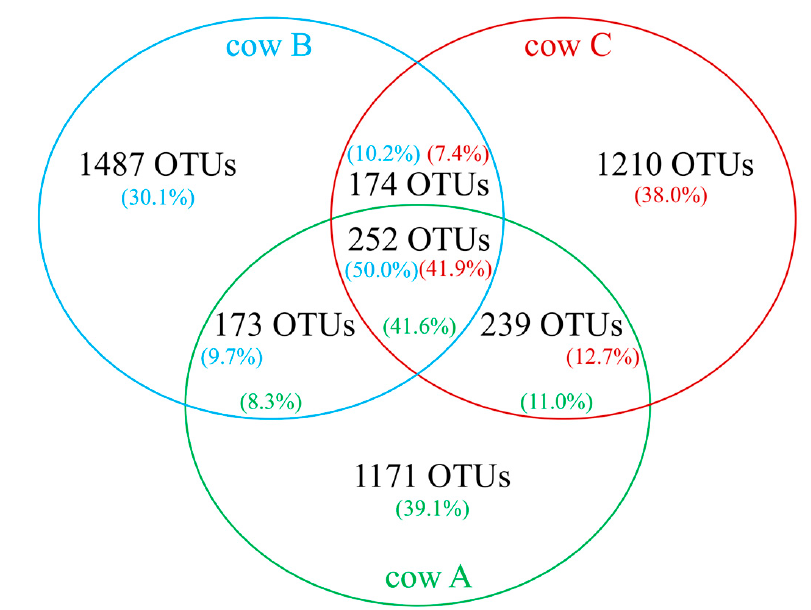
Figure 1. Venn diagram showing the number of shared rumen bacterial OTUs amongst three beef cows maintained under a forage diet. Also shown is the proportion of sequence reads from each rumen sample that were assigned to shared OTUs.